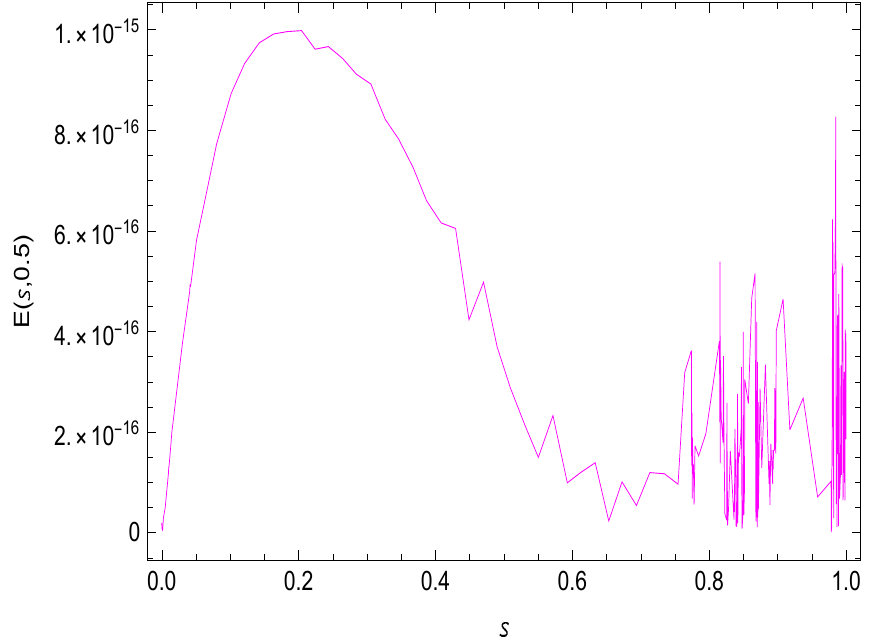
Figure 5. ς -absolute errors of the problem (17), where ε = 1.7, ν = 0.9 and N = M = K =